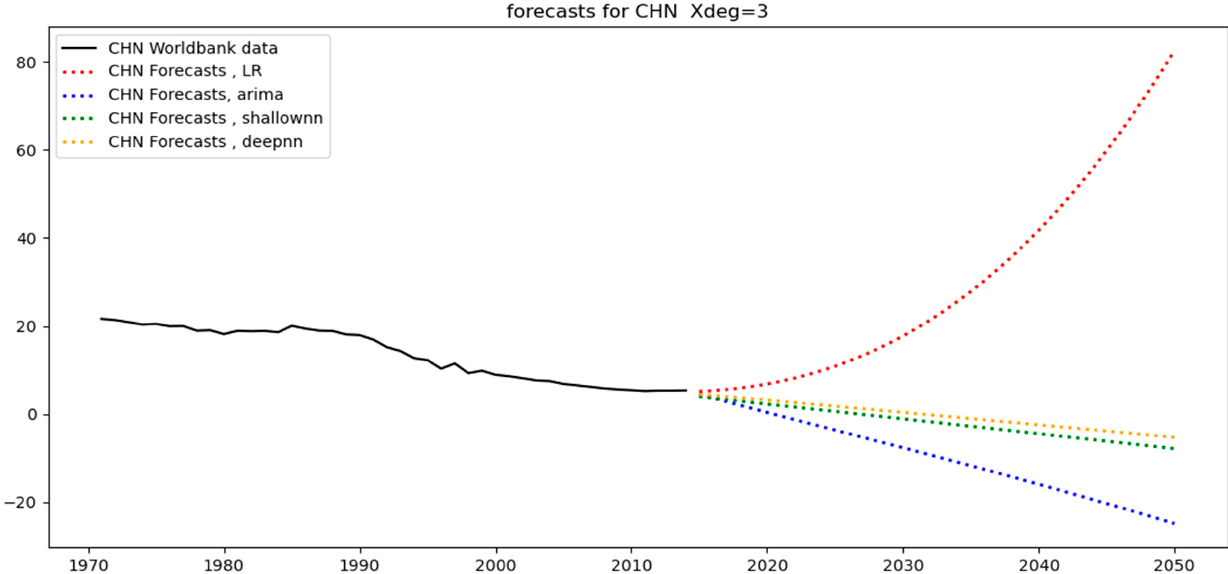
Figure 14. Forecasts for China (CHN), using linear regression (LR), ARIMA, shallow neural networks (shallownn), and deep neural network (deepnn) models (third-degree polynomial).